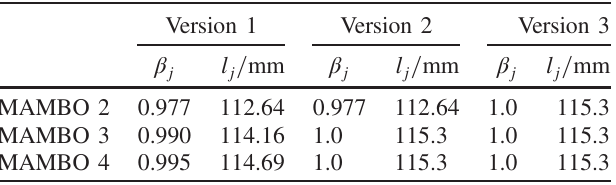
TABLE III. Length l of the cells of the rf sections MAMBO 2 – j 4 for different variations of the normal conducting concept. The lengths are measured from the center of the two neighboring coupling cells. The index j indicates the section number. Each tank consists of 17 AC and 16 CC. The shunt impedance is ≈ 19 kW for each R =L ¼ 44 . 9 M Ω = m, so P s c